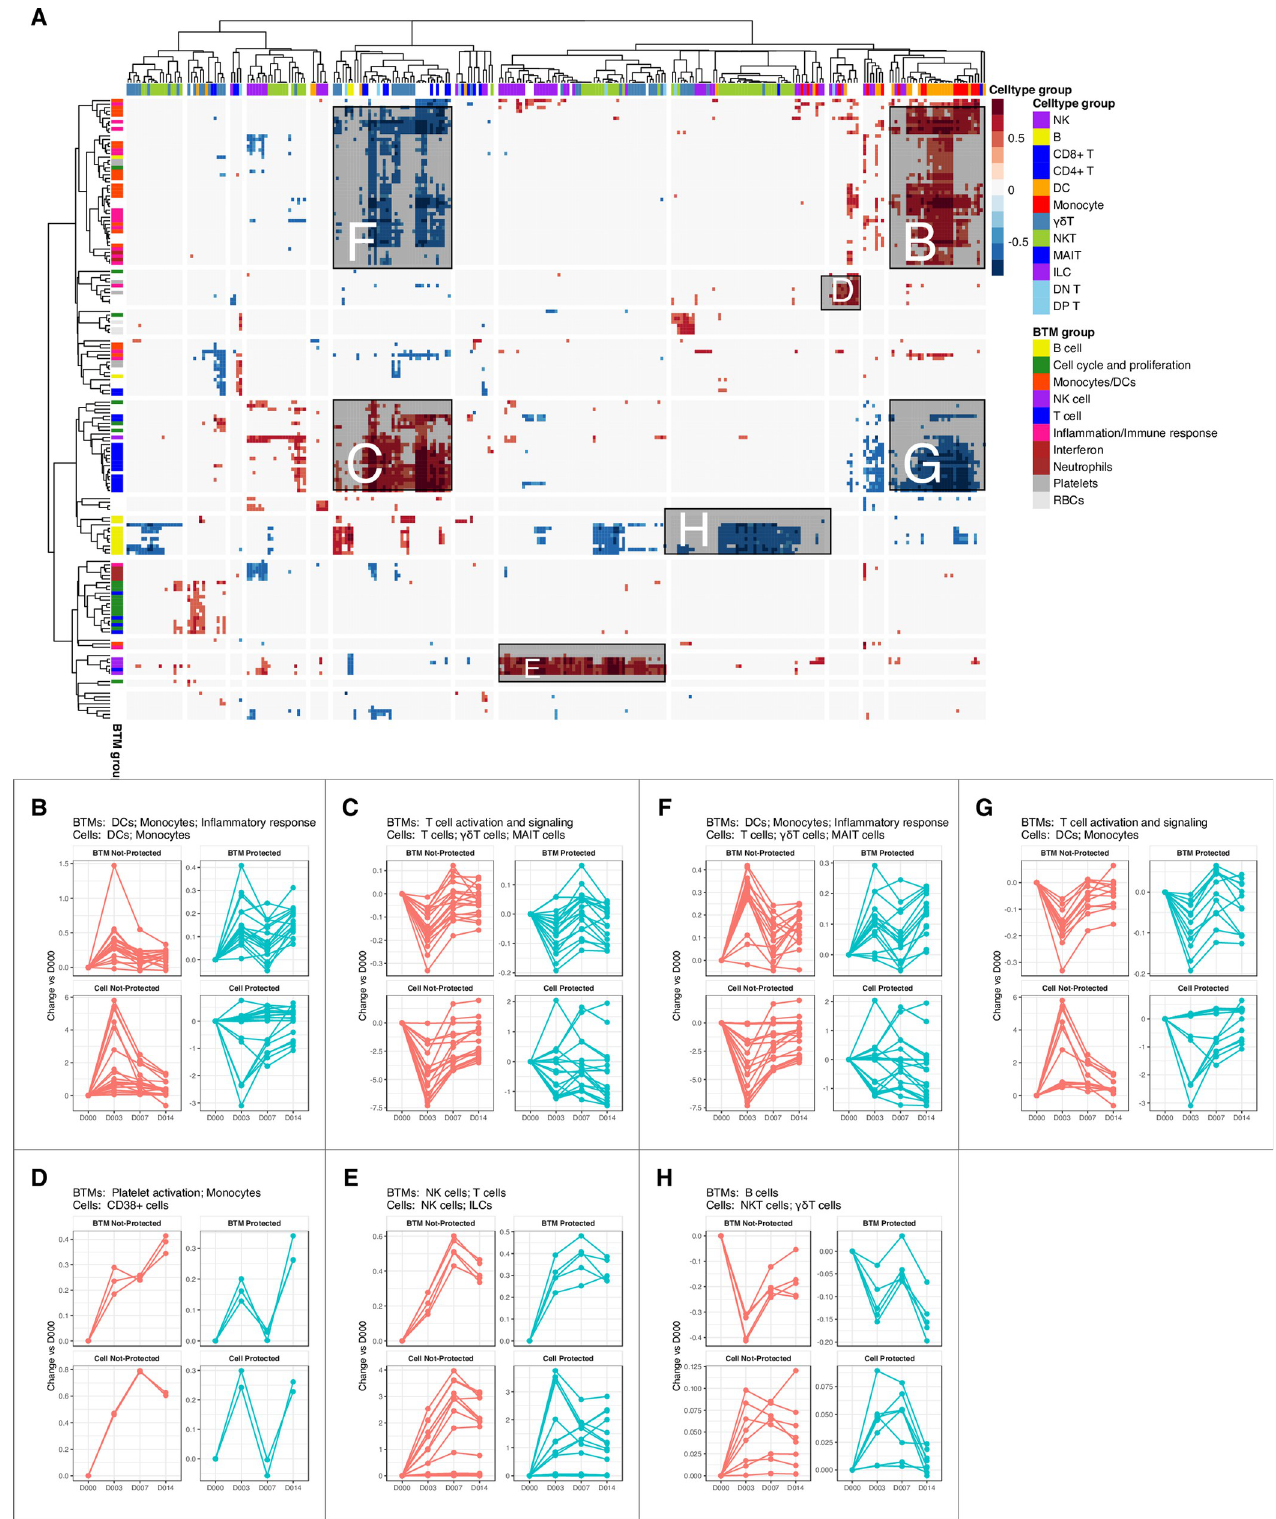
Fig 6. Correlation of temporal changes between cell subsets and BTMs. A. Heatmap showing correlations between flow-cytometry derived cell subset counts from NK and DC panels (columns) and BTM expression (rows) matched by participant and time-point. Red represents positive correlation, blue